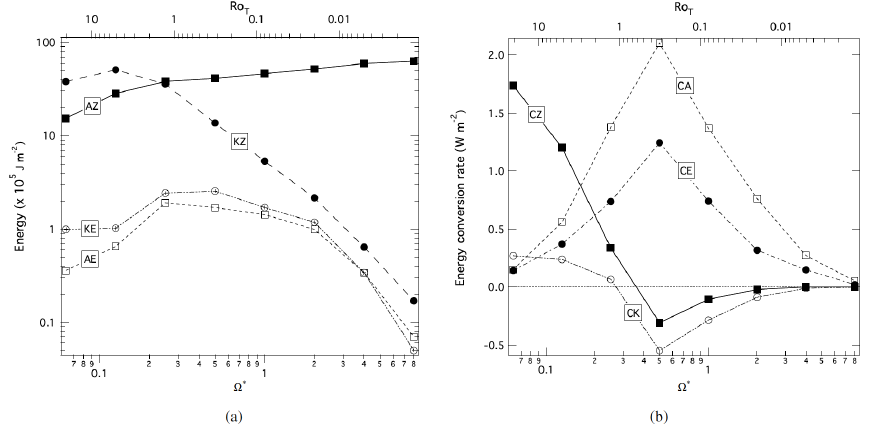
Figure 10. Terms in the Lorenz energy budgets for the series of PUMA simulations as a function of (cid:127) ∗ and the thermal Rossby number: (a) globally averaged energies (in 10 5 Jm − 2 ) and (b) the main energy conversion rates CZ, CA, CE and CK. Conversion rates are in the unit of watts per square